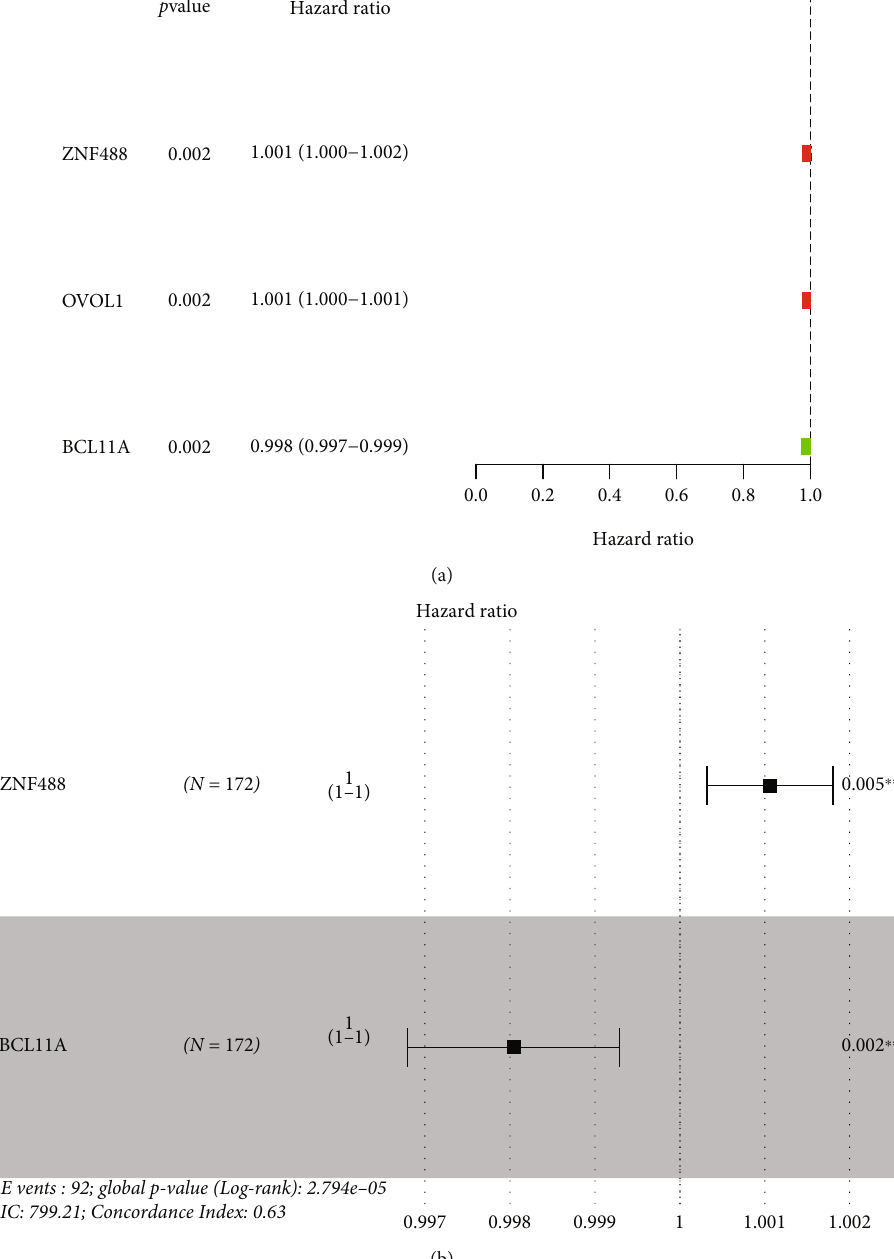
Figure 3: The survival-related TFs in PAAD patients. Forest plot of prognostic TFs by the use of (a) univariate assay and (b) multivariate